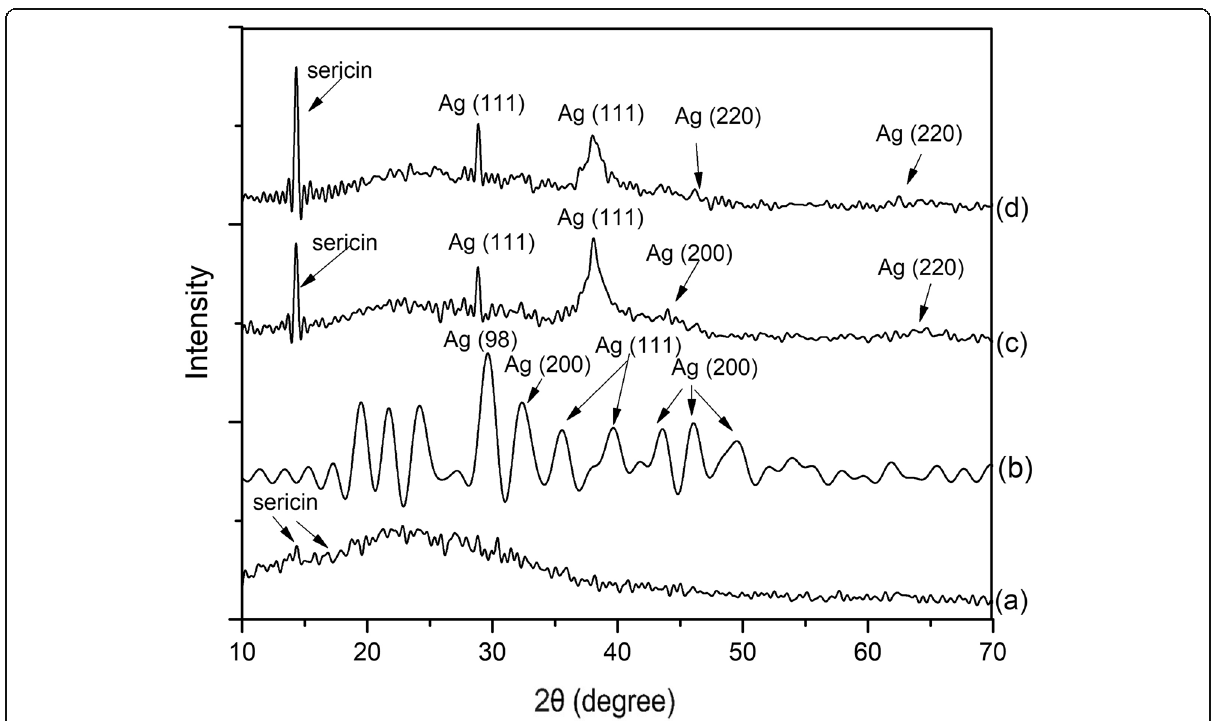
Fig. 4 X-ray diffraction diagram of a silk sericin, b AgNO 3 solution, c 1:6 SS-AgNPs, and d 1:8 SS-AgNPs